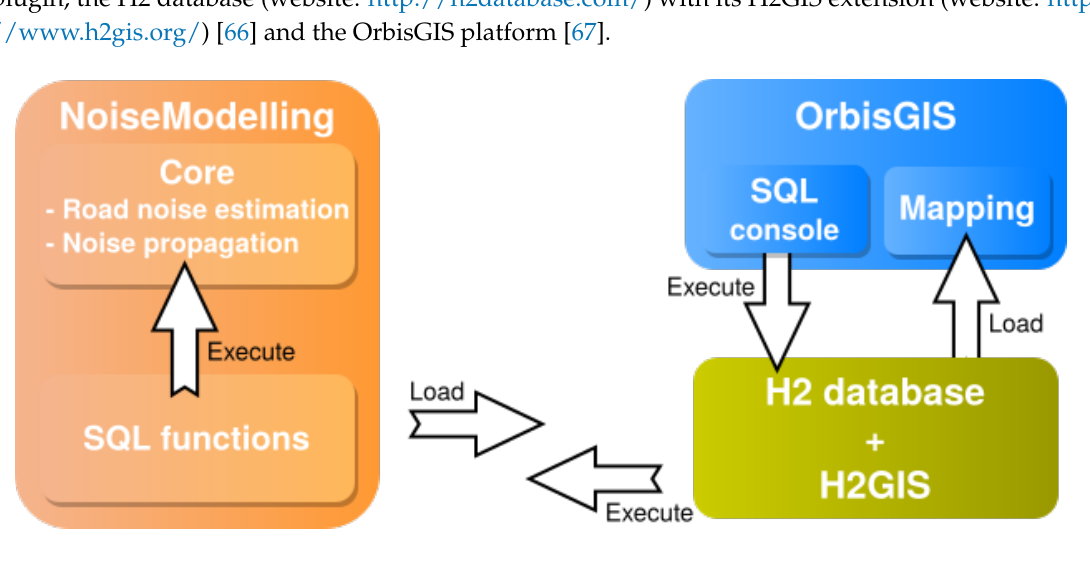
Figure 6. NoiseModelling